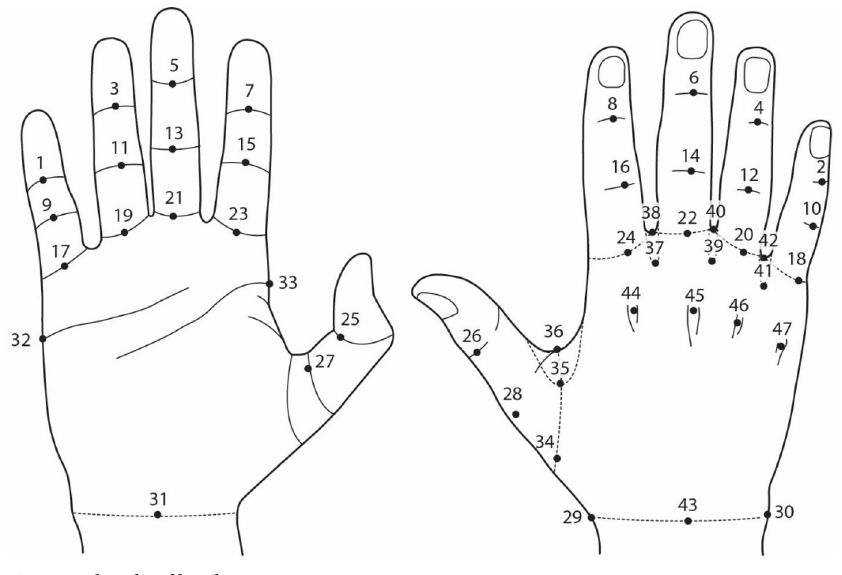
Fig 1. Landmarks of